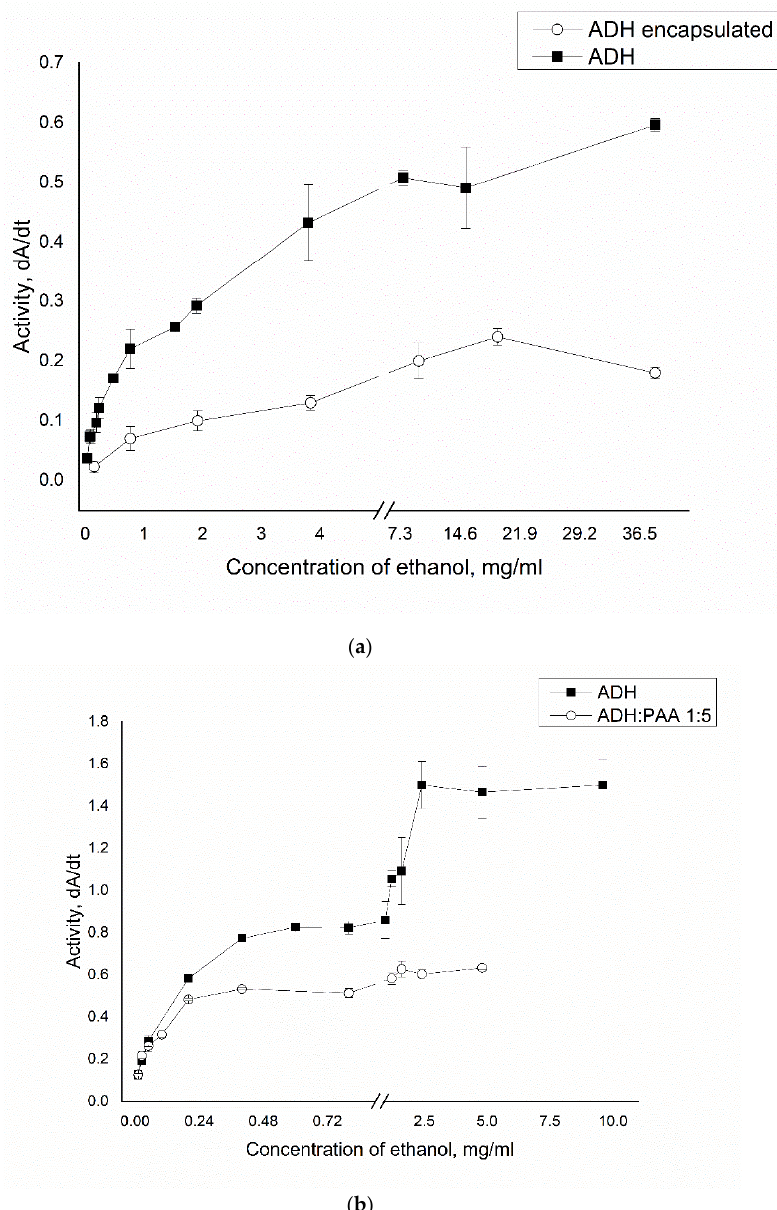
Figure 5. The dependence of the activity of ADH in the native state, in combination with PAA ( b ) and in capsules ( a ) on the concentration of ethanol.